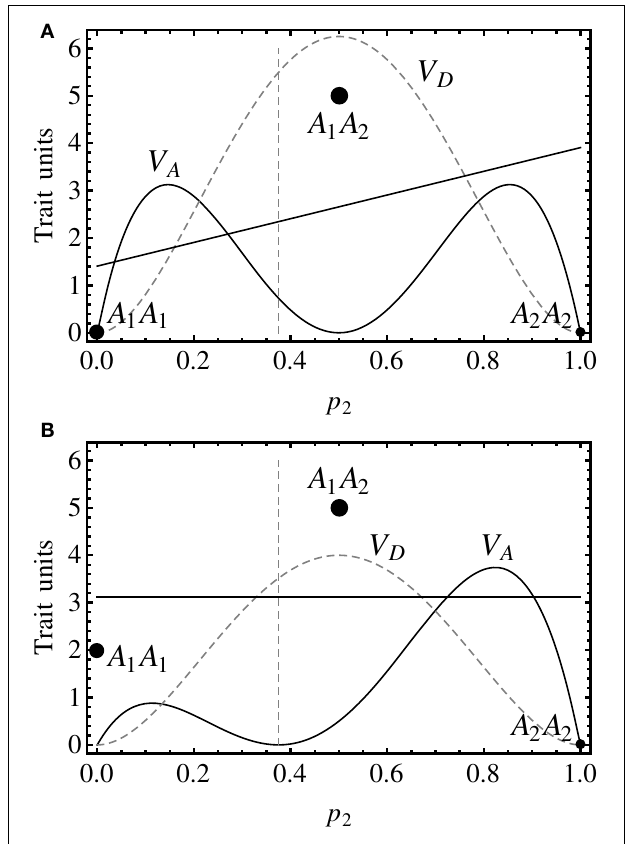
FIGURE 1 | Genotypic values (discs) and variance decomposition (curves) of one-locus, two-allele ( A 1 and A 2 ), non-imprinted genetic systems with overdominance assuming Hardy–Weinberg proportions for all possible allele frequencies (represented by the frequency of A 2 , p 2 ). The variances (black solid curve for additive, gray dashed curve for dominance) are actually plotted as trait units squared. The size of the discs marking the genotypic values are scaled according to p 1 = 0 . 625 (approximately, p 11 = 0 . 14, p 12 = 0 . 47, p 22 = 0 . 39). (A) Thegenotypicvalues are G 11 = 0, G 12 = 5, G 22 = 0, leading to individual-referenced genetic effects(fromthereferenceof A 1 A 1 ) a = 0, d = 5.At p 2 = 0 . 375( p 1 = 0 . 625, marked by the vertical dashed line), the regression of the genotypic values on the proportional allele content (solid line) is an increasing function with slope (and thus population-referenced additive effect) α = 2.5, indicating that p 2 would increase under directional selection (toward the equilibrium point, p 1 = p 2 = 0 . 5). (B) The genotypic values are the same as in (A) but for G 11 = 2, leading to individual referenced genetic effects of a = − 1, d = 4. At p 2 = 0 . 375 ( p 1 = 0 . 625, marked by the vertical dashed line), the regression of the genotypic values on the proportional allele content (solid line) has α = 0 slope, indicating a polymorphic equilibrium